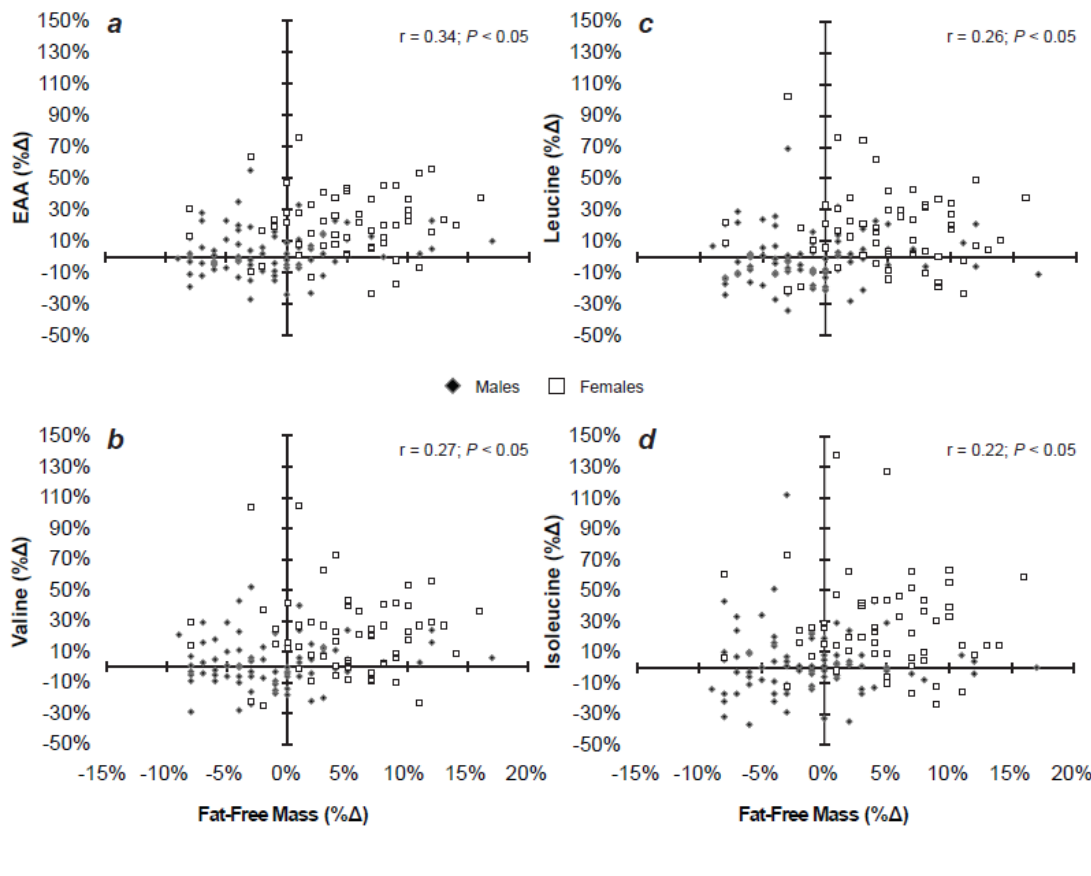
Figure 1. Relationships between changes in fat-free mass and plasma ( a ) essential amino acids; ( b ) valine; ( c ) leucine; ( d ) and isoleucine. n = 140 (81 males, 59